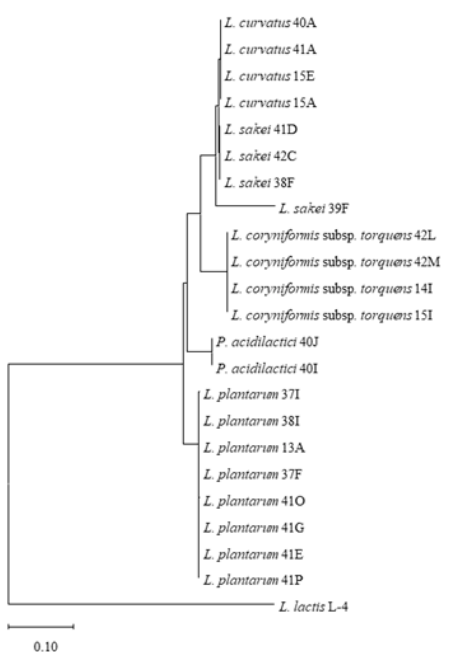
Figure 2. Phylogenetic tree based on the 16S rRNA gene sequences of 22 selected LAB species. Lactococcus lactis L-4 was applied as the outgroup.